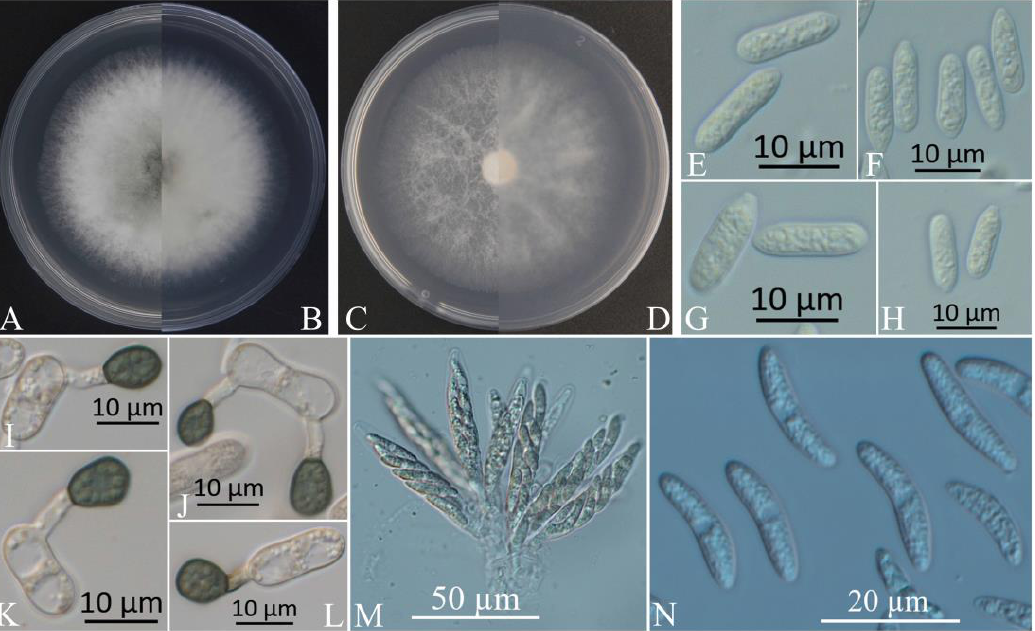
Figure 3. Morphological characteristics of XZEC21 . ( A , B ) Front and reverse views of 4-day-old fungus on PDA, respectively. ( C , D ) Front and reverse views of 4-day-old fungus on SNA, respectively. ( E – H ) Conidia. ( I – L ) Appressoria. ( M ) Asci. ( N ) Ascospores. Scale bars: ( E – L ) = 10 μm; ( M ) = 50 μm; ( N ) = 20 μm.